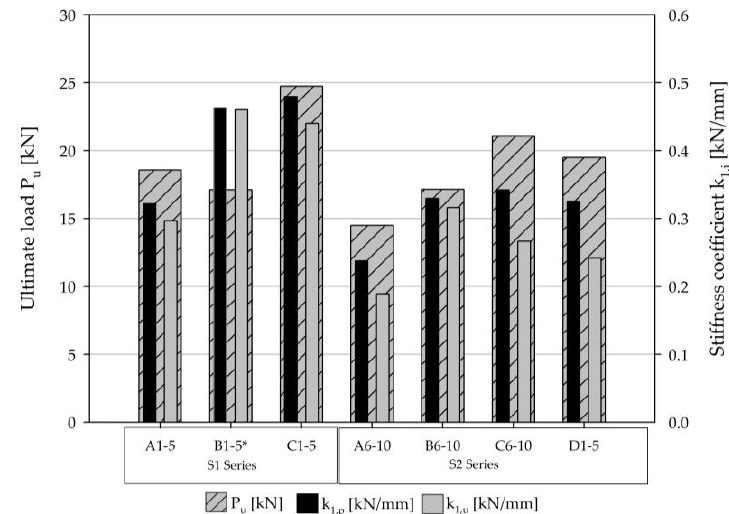
Figure 7. Ultimate load-bearing capacity and stiffness coefficient of the tested specimens of types A, B, C, and D.